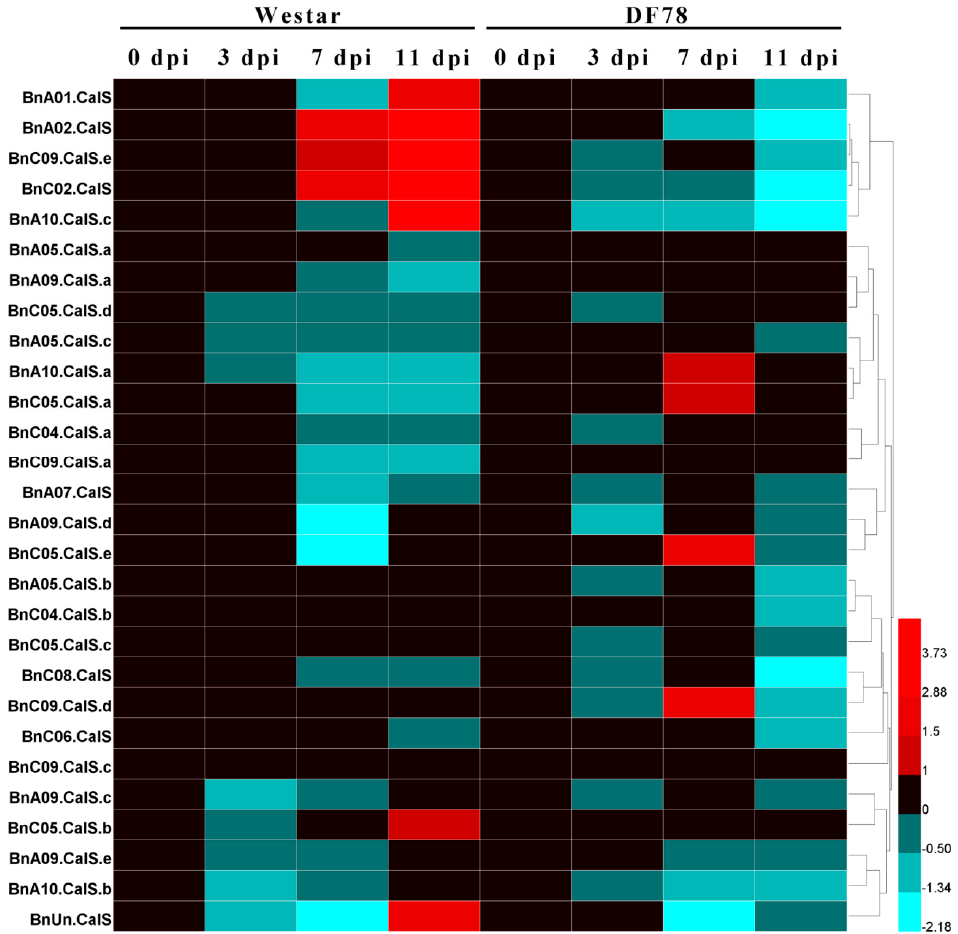
Figure 9. Heatmap of the expression patterns of the 28 BnCalS genes in Westar and DF78 after inoculation with D3 isolate for different time periods. Expression levels were measured in transcripts per kilobase of exon model per million mapped reads (TPM) values, ratio values were from comparing the TPM value of the L. maculans treated sample with that of the mock-treated sample. The color scale bar at the bottom of the map represents a log2 ratio value, which represents the low and high expression, respectively. Varieties and corresponding treatments used for expression profiling are indicated at the top of each column. The names of genes are indicated on the left side of the heatmap.